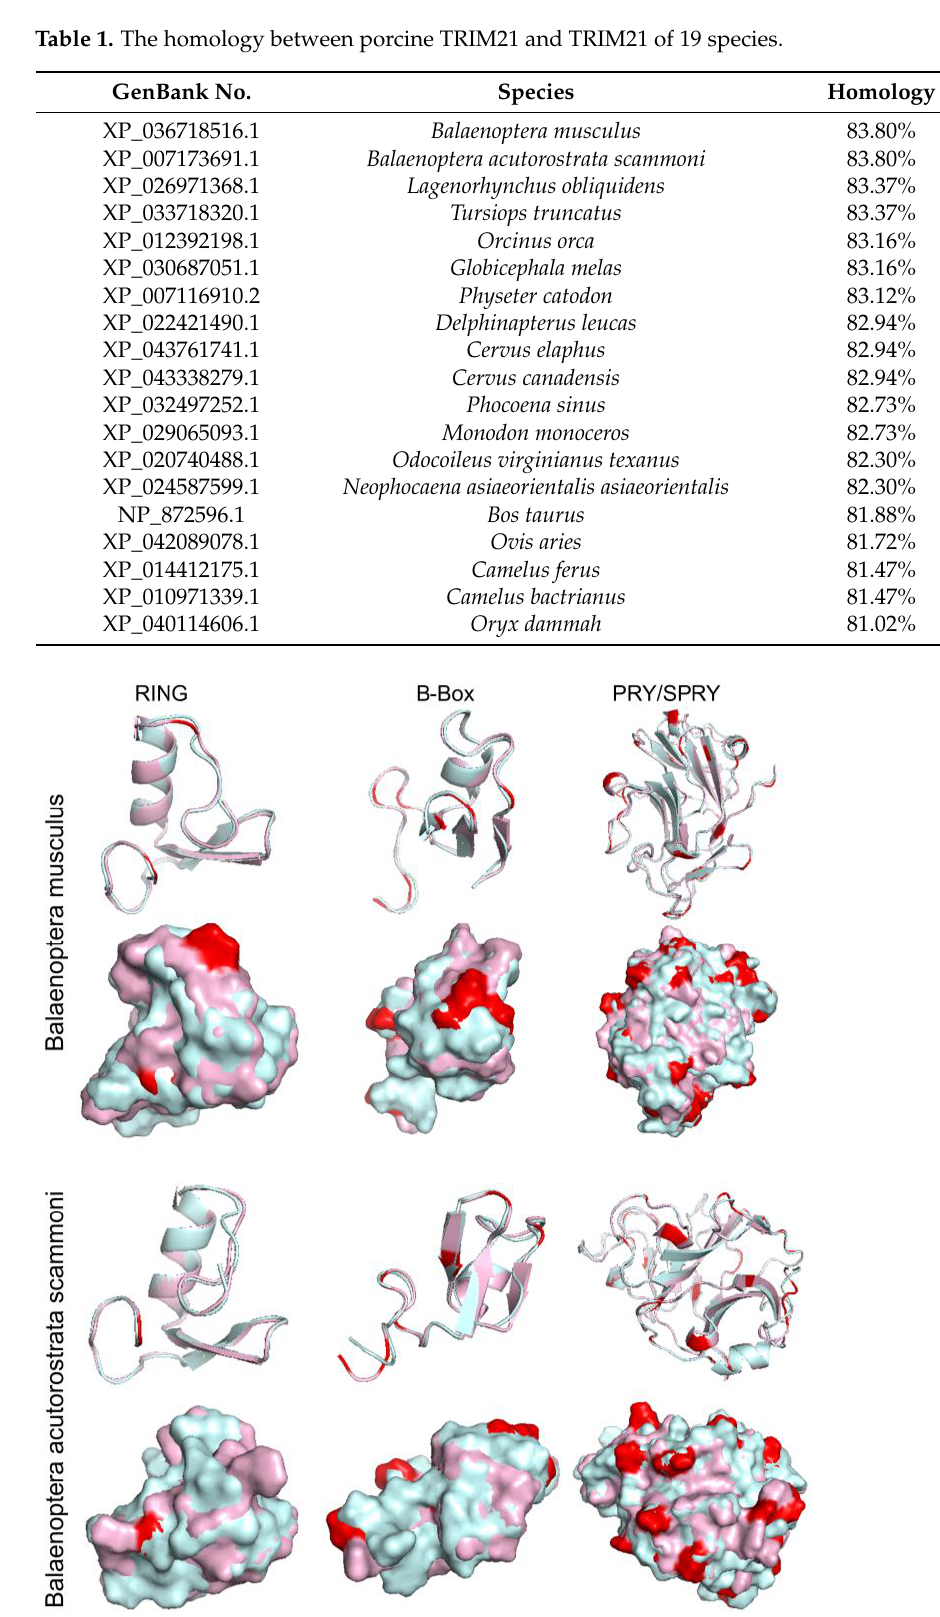
Figure 3. Predicated structural similarity between porcine TRIM21 and TRIM21 of B. musculus or B. acutorostrata scammony. Palecyan, porcine TRIM21; light pink, TRIM21 of B. musculus or B. acutorostrata scammony. Red indicates different residues of the RING and B-Box domains of TRIM21.